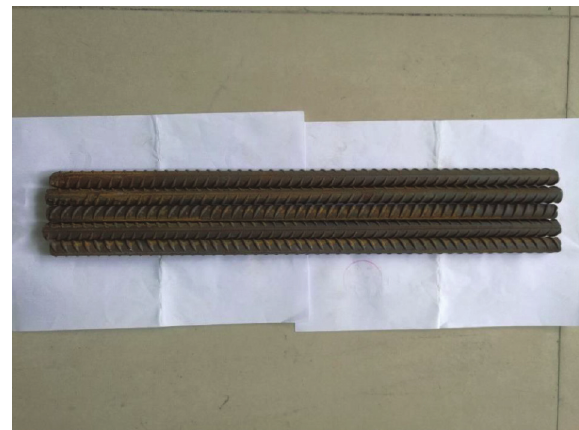
Figure 2: Rebars used in the experiments.